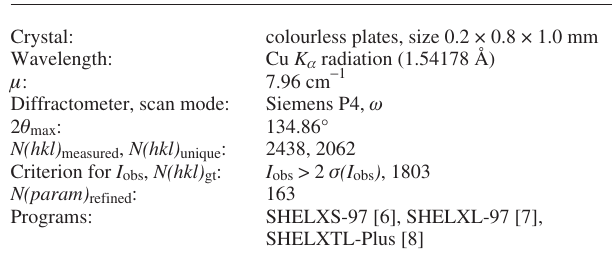
Table 1. Data collection and handling.